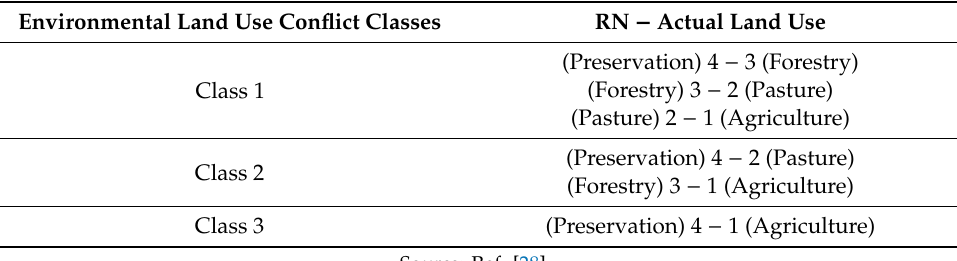
Table 2. Criteria for determining environmental land use conflicts.